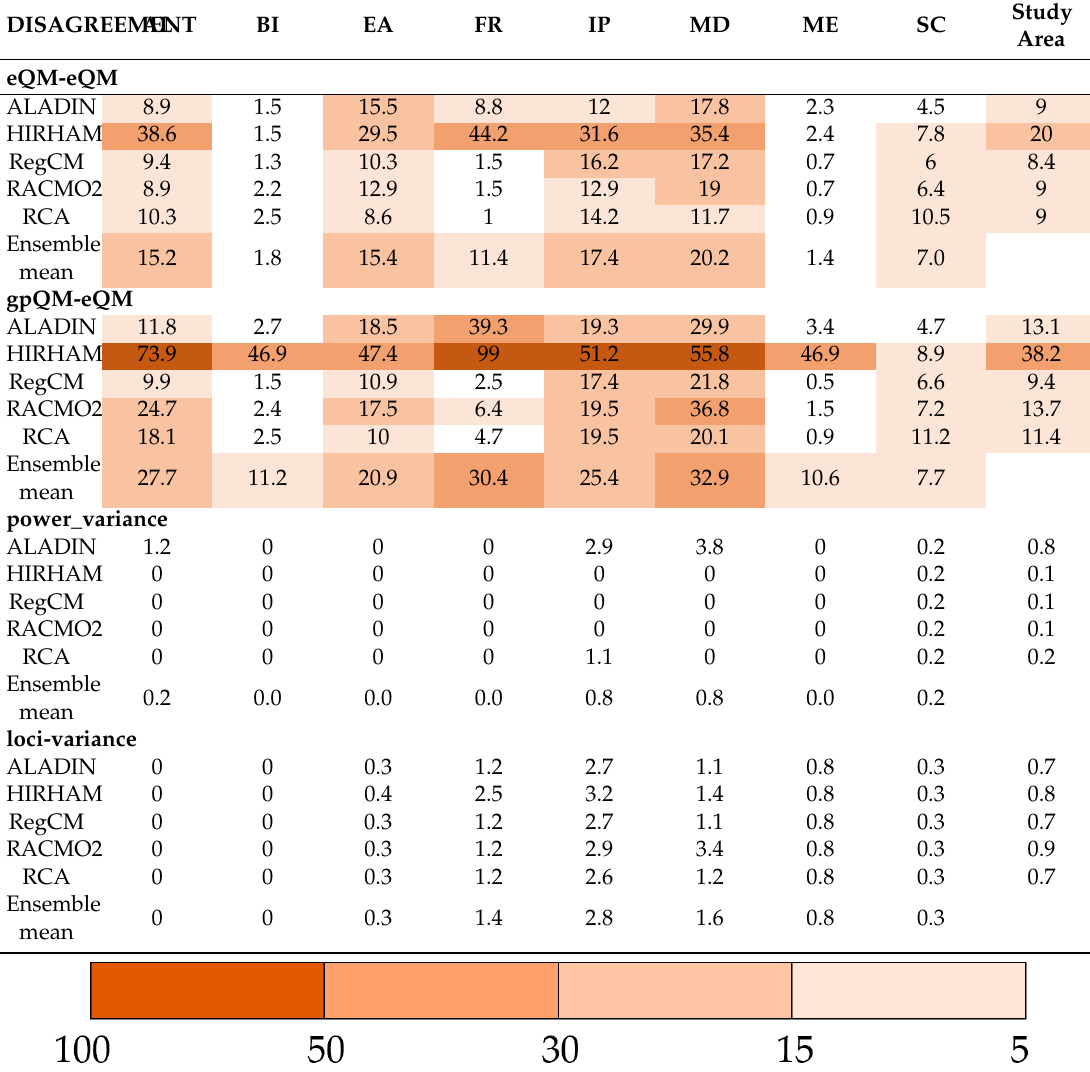
Table 11. Disagreement between observed and simulated K-G zones in eight different regions: the Alps (AL), the British Isles (BI), Eastern Europe (EA), France (FR), the Iberia Peninsula (IP), the Mediterranean (MD), Mid-Europe (ME) and Scandinavia (SC) and in the whole study area in DJF and JJA in the case of eQM-eQM, gpQM-eQM, power transformation of precipitation and variance scaling of temperature and LOCI and variance scaling of temperature bias correction combination. The values are in %. Study BI EA FR MD